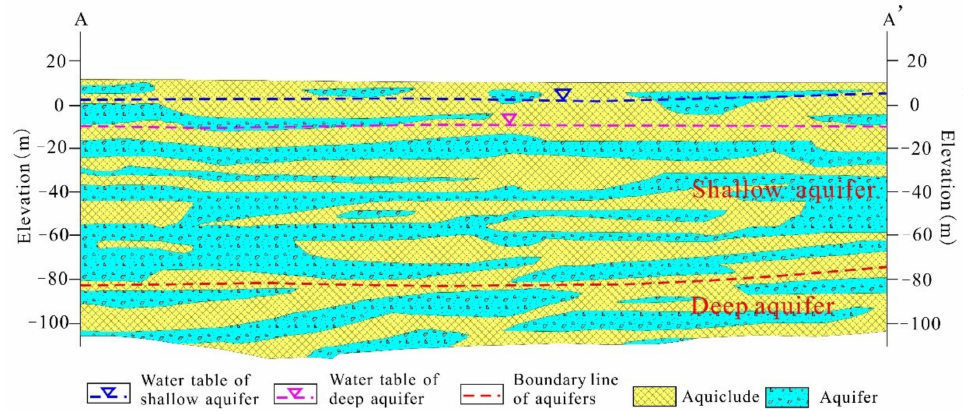
Figure 2. Hydrogeological cross section of the study